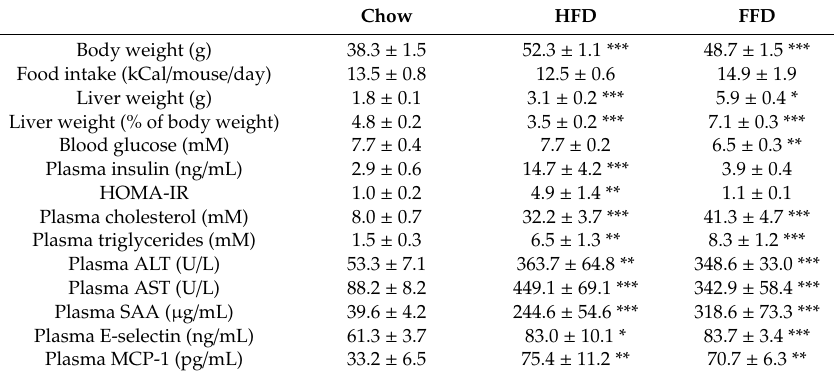
Table 1. Metabolic parameters.